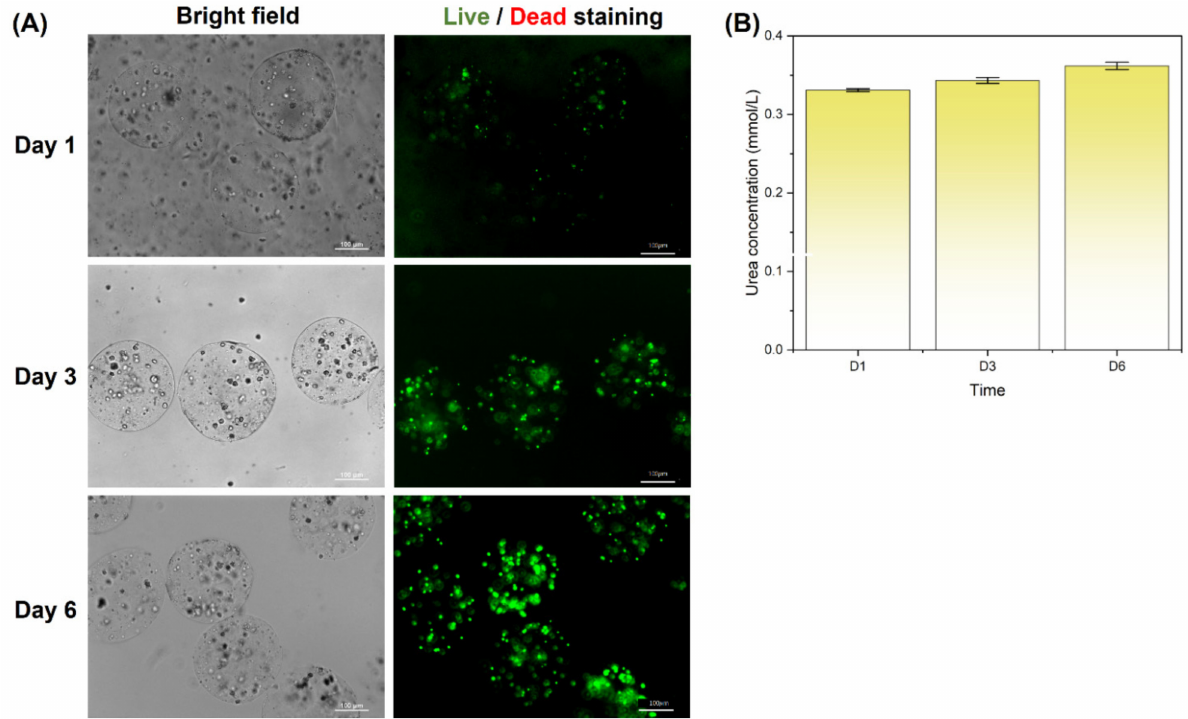
Figure 6. Long-term cellular viability and functioning inside alginate-gelatin microspheres: ( A ) live/dead staining of HepG2 cells encapsulated inside alginate–gelatin microspheres at days 1, 3, and 6 post-encapsulation. ( B ) Urea secretion of HepG2 cells encapsulated inside alginate–gelatin microspheres at days 1, 3, and 6